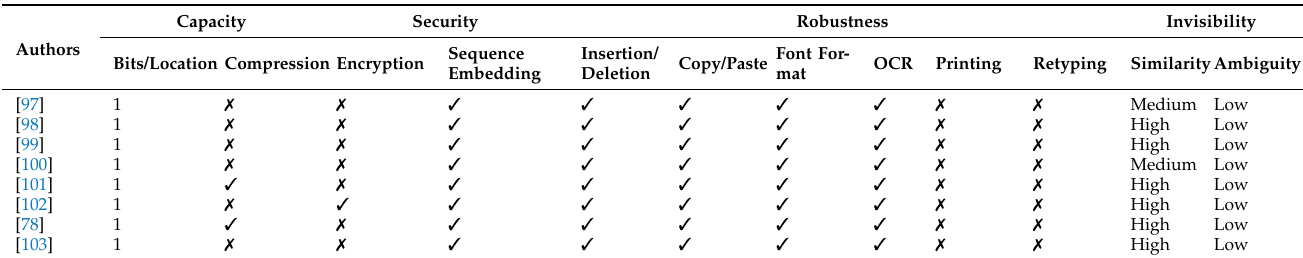
Table 23. Evaluation of Unicode method based on invisibility and robustness and capacity.